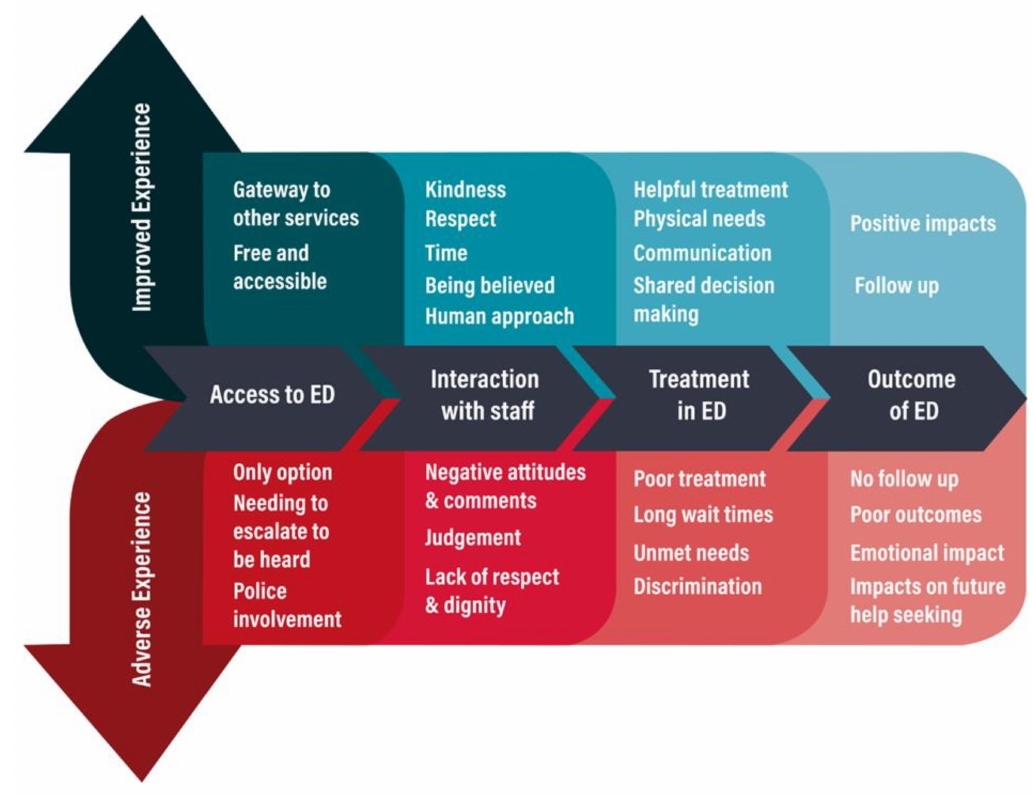
Figure 2. Journey of experiences in